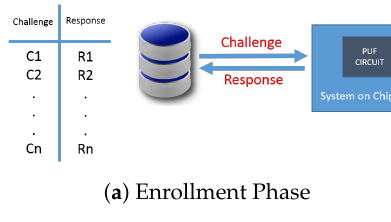
Figure 2. PUF authentication